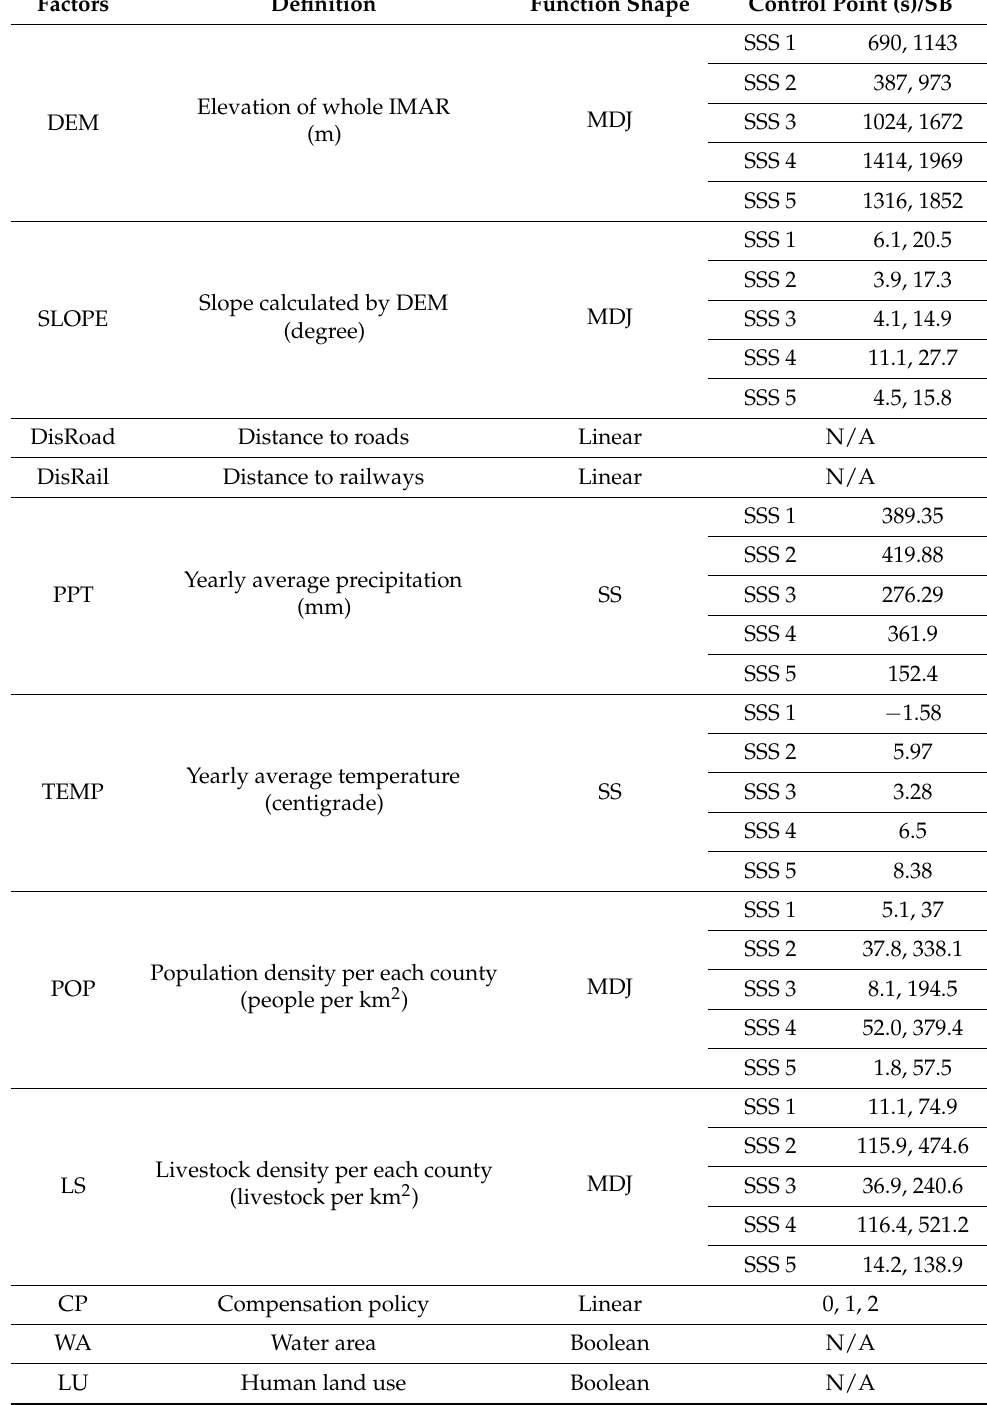
Table 2. Suitability